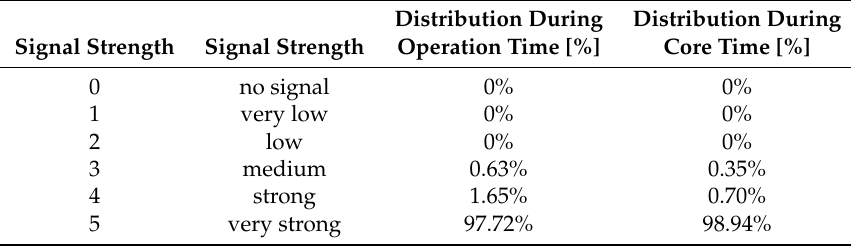
Table 3. Distribution of Iridium’s signal strength over time in [%] measured on-board. Distribution